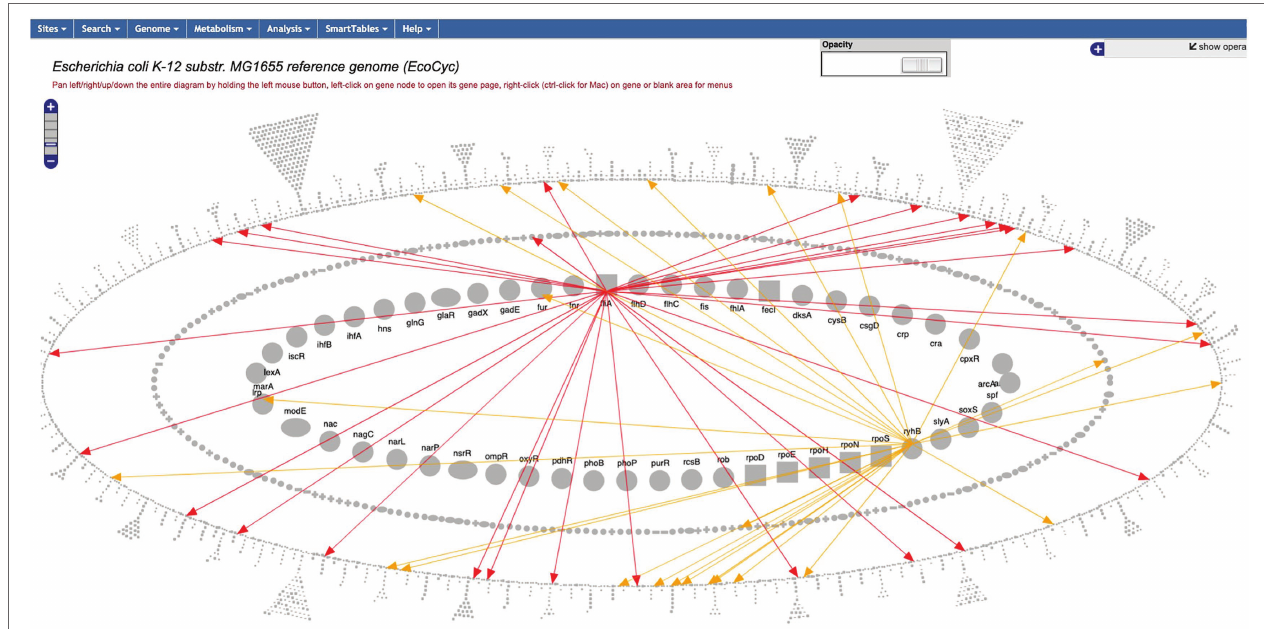
FIGURE 6 | The Regulatory Overview diagram captures user-specified portions of a regulatory network. The user has specified the display of regulation by FliA (red) and RhyB